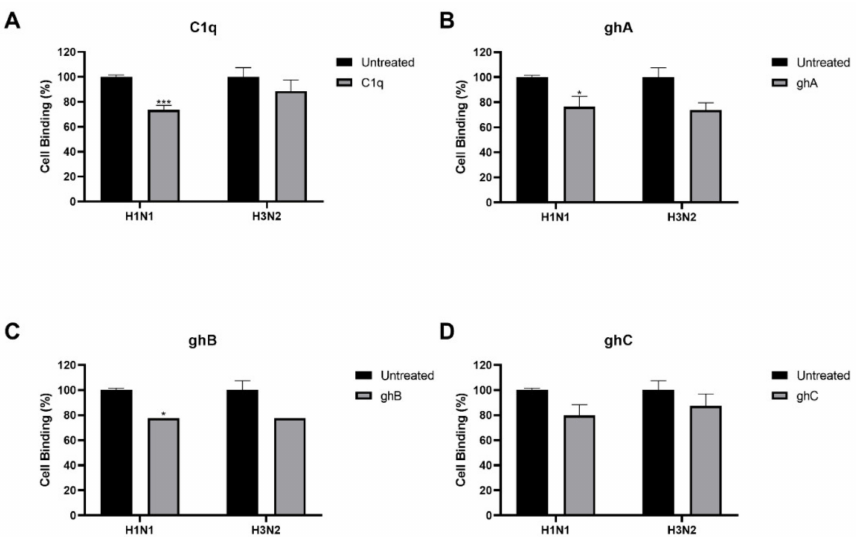
Figure 5. Pre-treatment of IAV with human C1q restricts H1N1 viral particles binding to the cell surface. A549 cells (1 × 10 5 cells/mL) were infected with H1N1 or H3N2 viral particles pre-incubated with or without human C1q ( A ), ghA ( B ), ghB ( C ) or ghC ( D ) (20 µ g/mL). Then, 2 h post-infection, un- bound protein and viral particles were removed, and the wells were fixed with 1% v / v paraformalde- hyde for 1 min. The wells were probed with the corresponding primary antibodies: monoclonal anti-influenza virus H1 or polyclonal anti-influenza virus H3 antibodies (1:5000). Data are shown as the normalized mean of three independent experiments performed in triplicate ± SEM. Data were normalized to the absorbance of its untreated control (cells + virus only). Significance was determined using the two-way ANOVA test (* p < 0.05, *** p < 0.001, ( n =